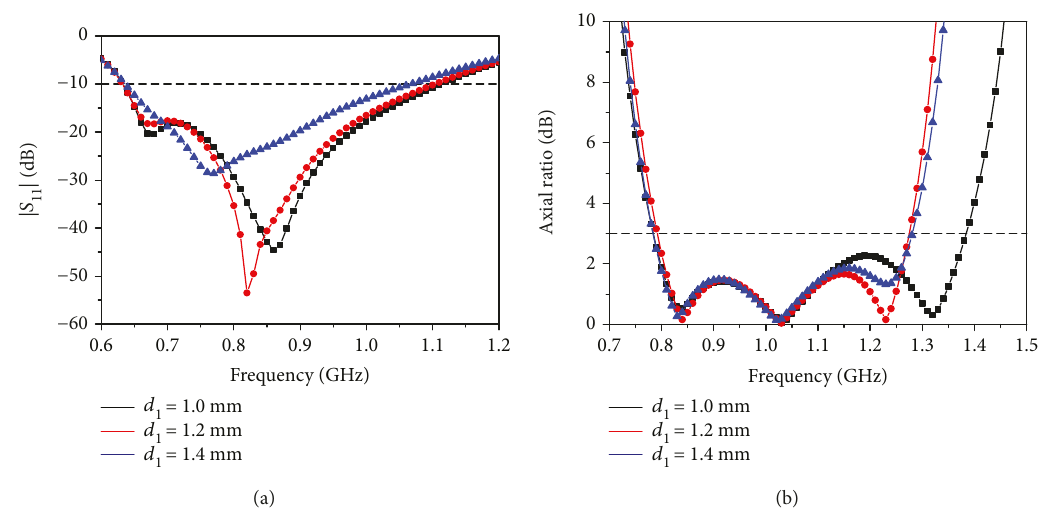
ff erent signal strip widths ( d